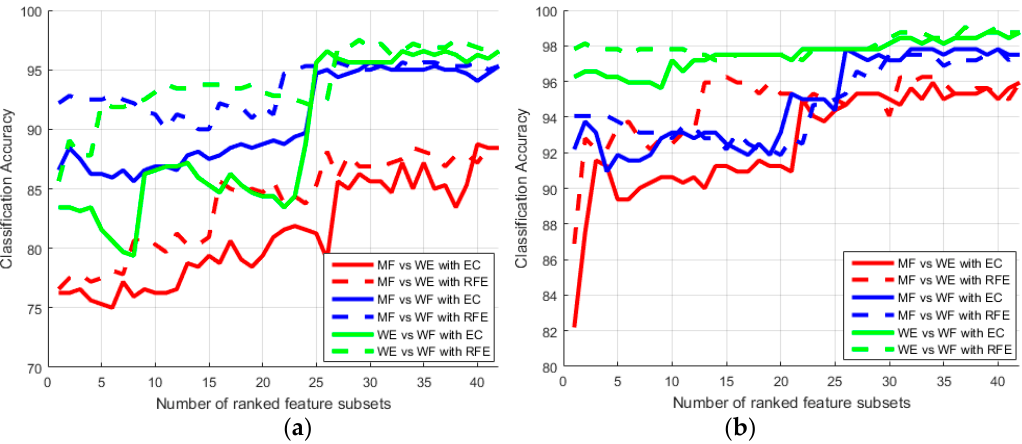
Figure 9. Comparisons of the RFE and EC methods. Evolution of classification accuracies was computed with feature subsets increasing according to different separability ranks: ( a ) classification accuracies of three pairs of motions for subject S6; ( b ) Same results for subject S7.